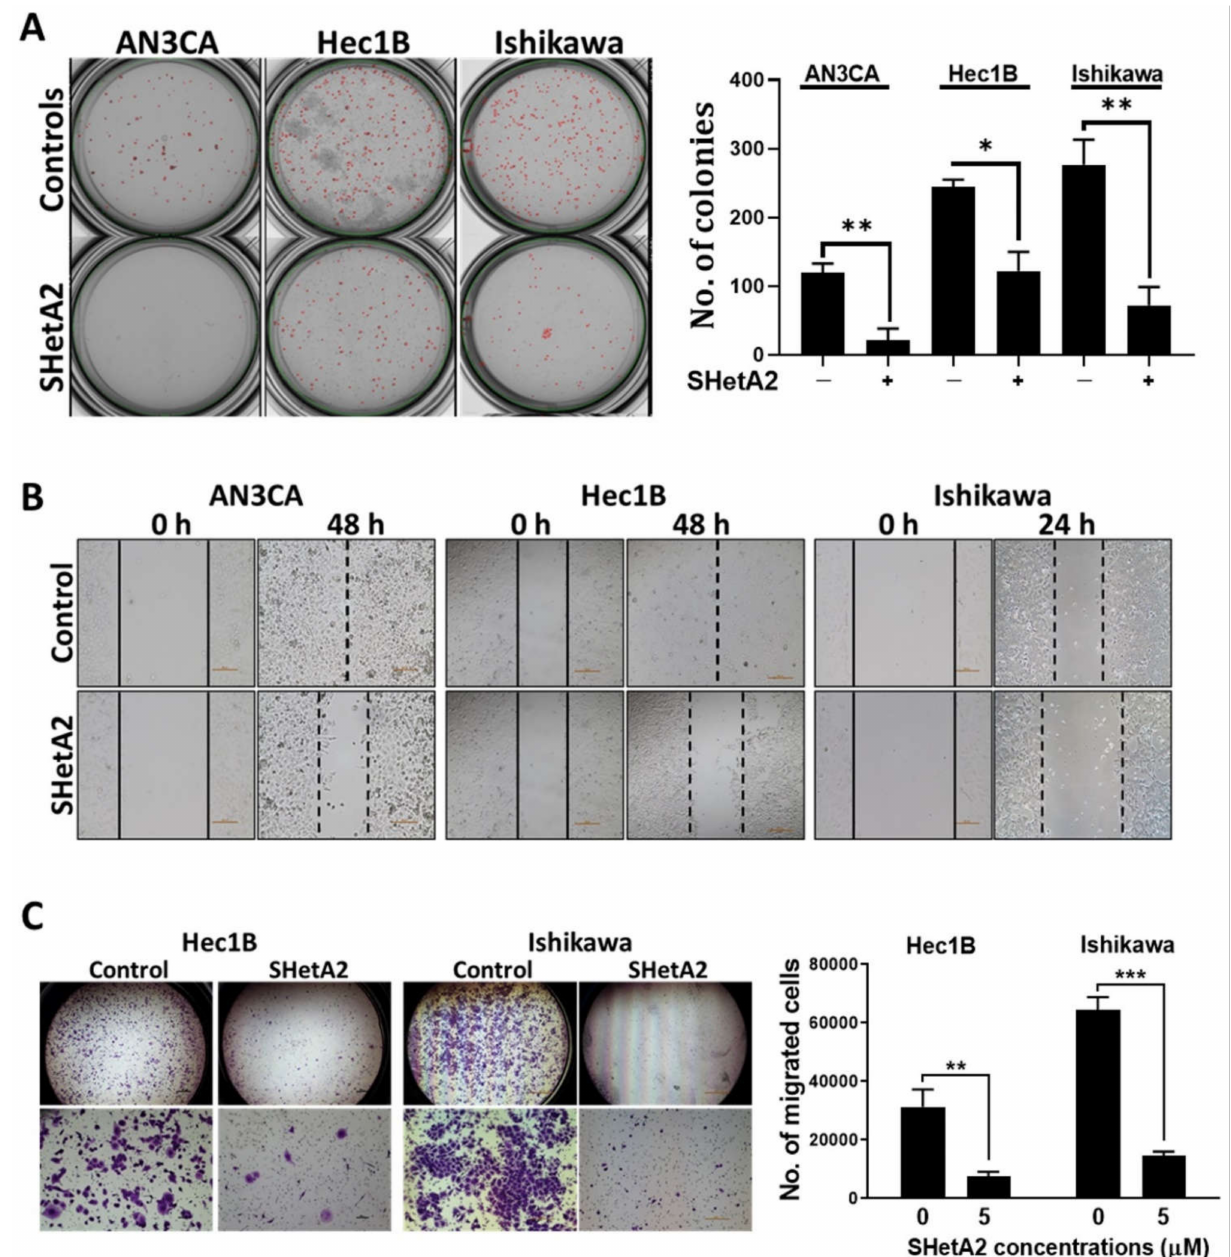
Figure 1. SHetA2 attenuates cancerous phenotypes of endometrial cancer cell lines: ( A ) Soft agar colony formation assay of endometrial cancer cells treated with 5 µ M SHetA2 or vehicle. After 3 weeks of culture, colonies were imaged (left panel) and counted (right panel) using q GelCount colony counter. Representative images scanned at 4 × magnification are shown. The controls were set as 100% and data are shown as mean ± SD. ( B ) Wound healing scratch assay of endometrial cancer cells treated with 5 µ M SHetA2 or vehicle. Images were captured at the indicated time points. ( C ) Invasion assays were conducted using the Matrigel-coated transwell chamber. Representative images of transwells showing invasion capacity of Hec1B and Ishikawa endometrial cancer cell in the presence of SHetA2 or vehicle are shown (left panel). The number of invaded cells were counted with a cell counter and shown (right panel). * p ≤ 0.05, ** p ≤ 0.01, *** p ≤ 0.001 when compared with respective